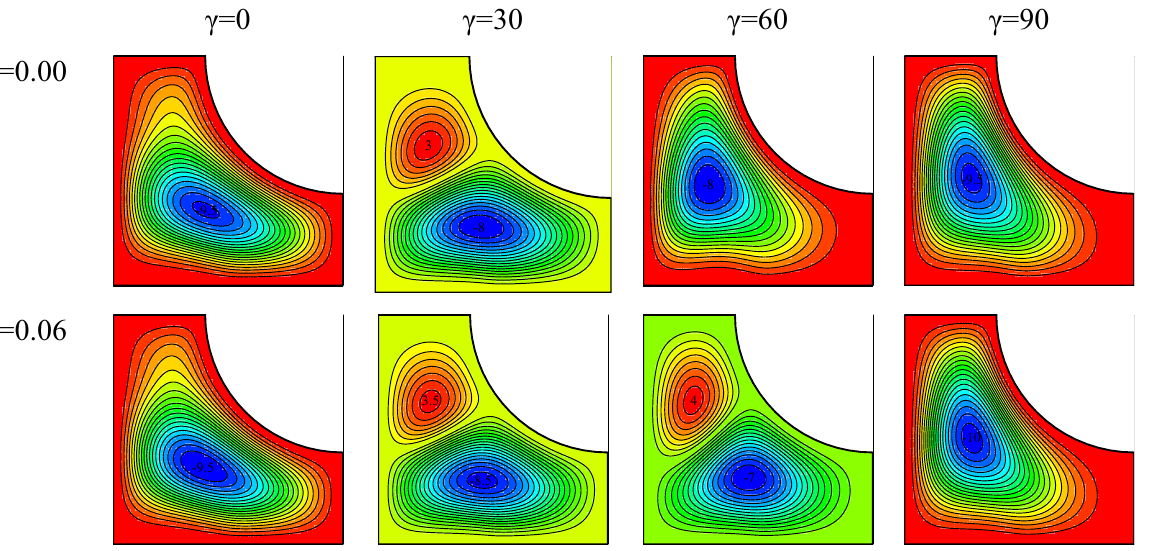
Figure 13. Flow field for Ra = 10 5 , ω = 0, Ha = 20, Rd = 1 and various nanofluid concentrations and cavity